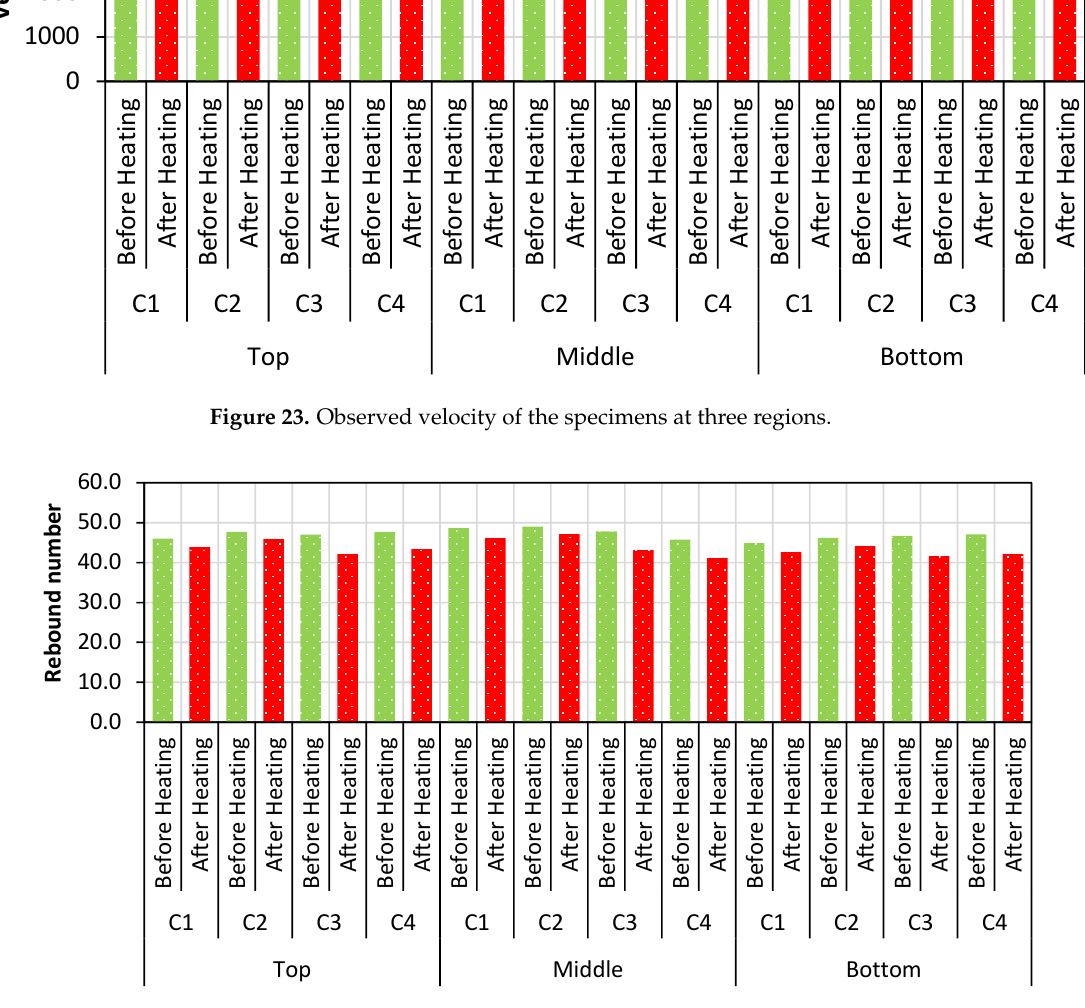
Figure 24. Rebound number of the specimens at three regions.